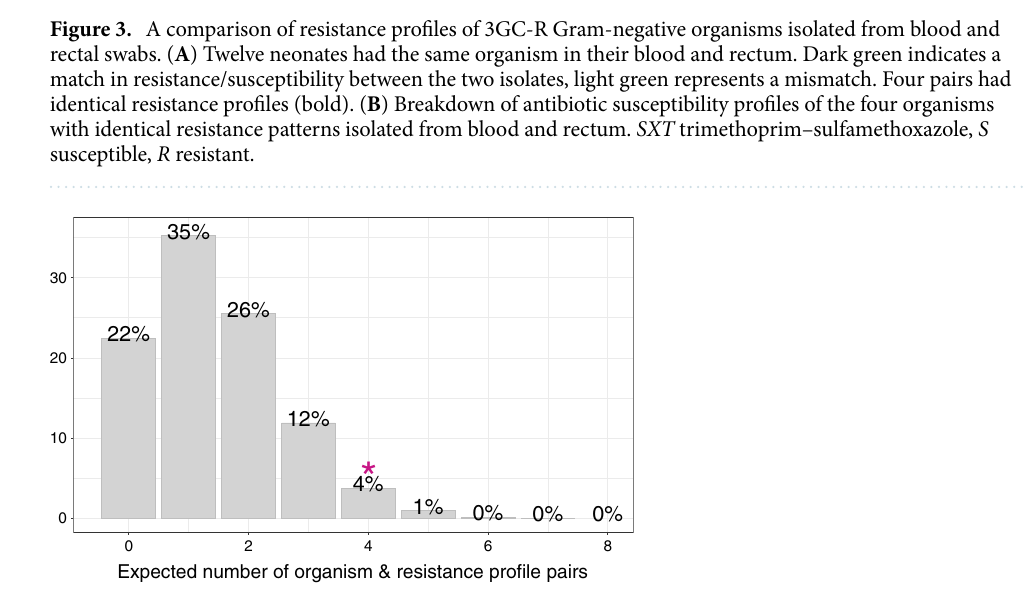
Figure 4. Expected number of matching organism and resistance profile pairs in neonatal blood and carriage